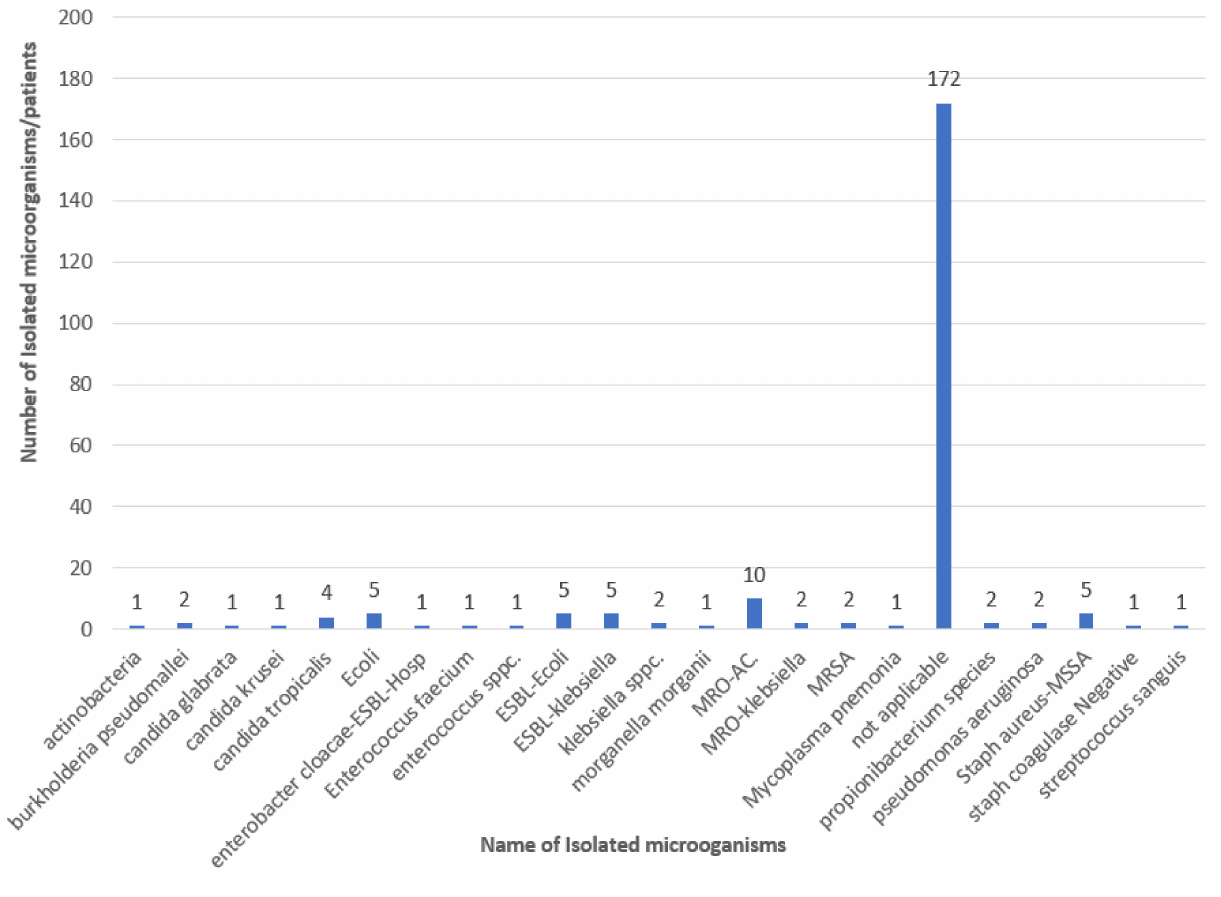
Figure 2. The total isolated microorganisms from blood culture. Not applicable = Number of samples without isolated microorganisms from the whole patients who were admitted to ICU